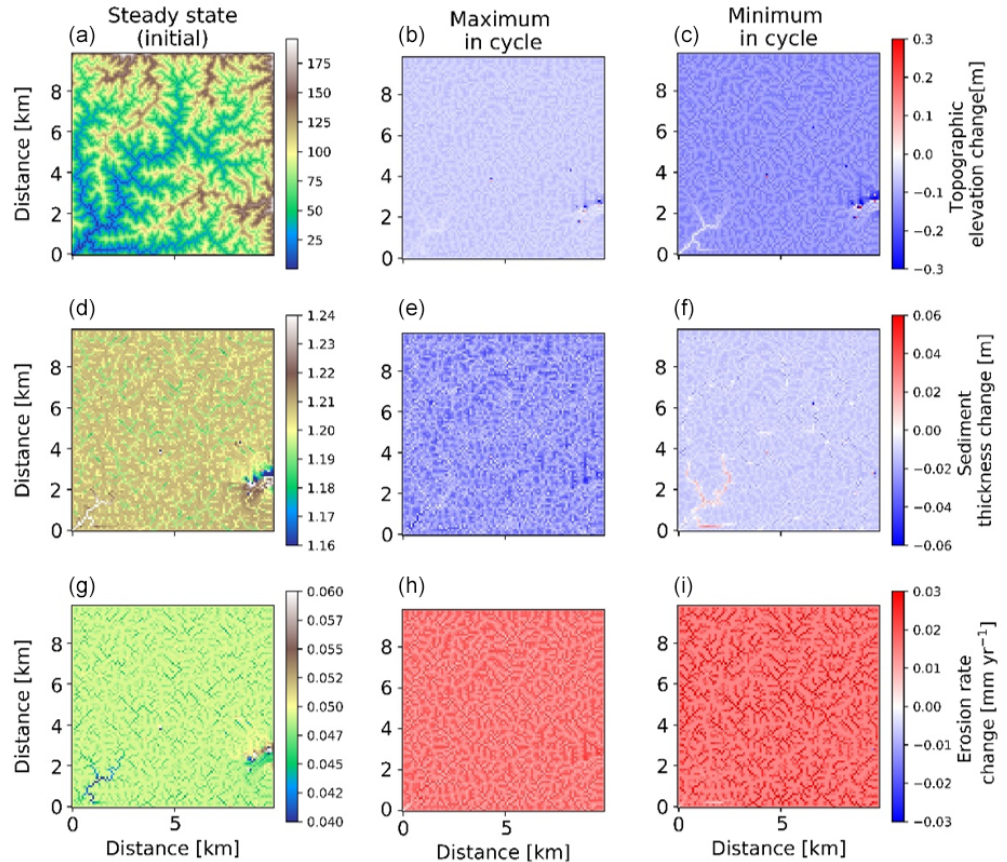
Figure 12. Two-dimensional map-view representation of changes in topographic elevations [m] (a–c) , sediment thickness [m] (d–f) , and erosion rates [mmyr − 1 ] (g–i) . These changes are represented with respect to steady-state conditions (a, d, g) for maximum (b, e, h) and minimum (c, f, i) values of precipitation and vegetation in an oscillation cycle. The simulations represent 10% initial vegetation